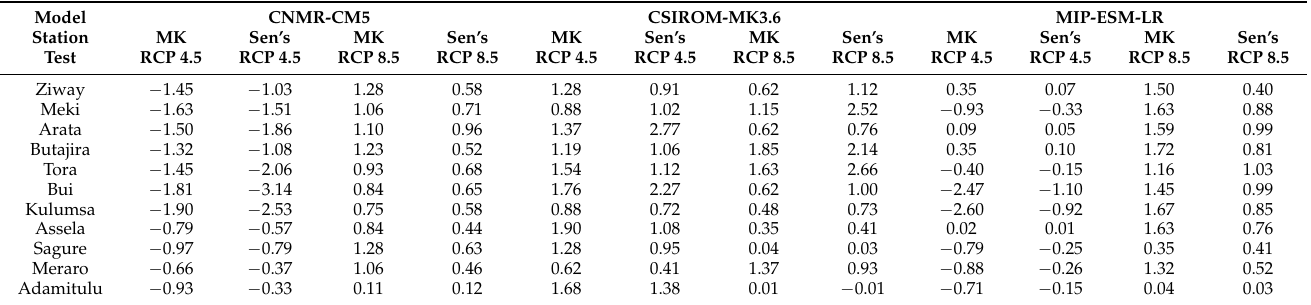
Table A7. Projected Mann–Kendall trend and Sen’s slope estimator results of annual average rainfall for 11 stations over Ziway Lake Basin from the period 2073–2100.